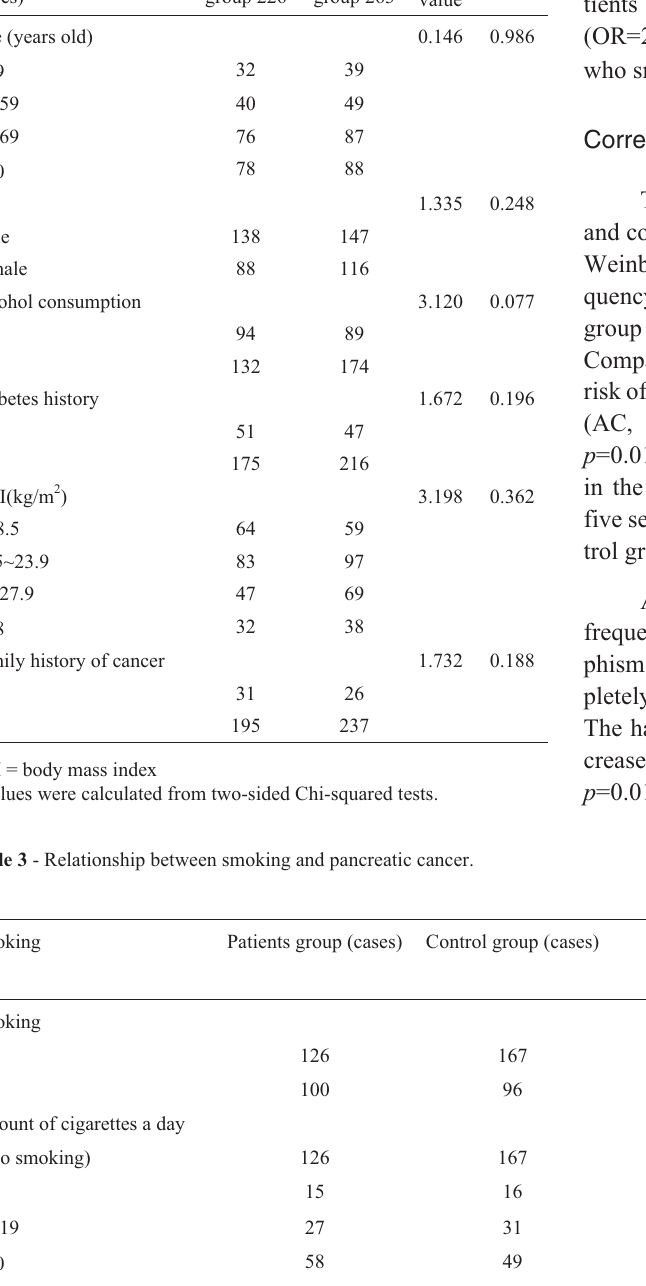
Table 2 - Comparison of clinical characteristics in pancreatic cancer pa- tients and controls. Clinical characteristics (cases)